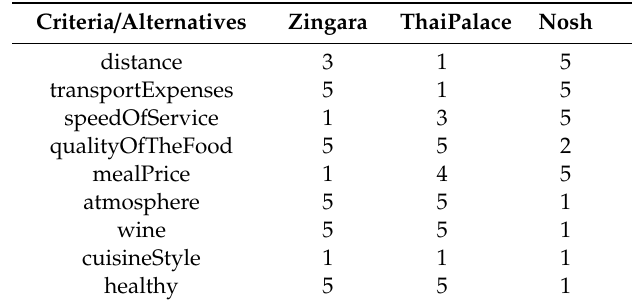
Table 8. The importance of each criterion to the existing